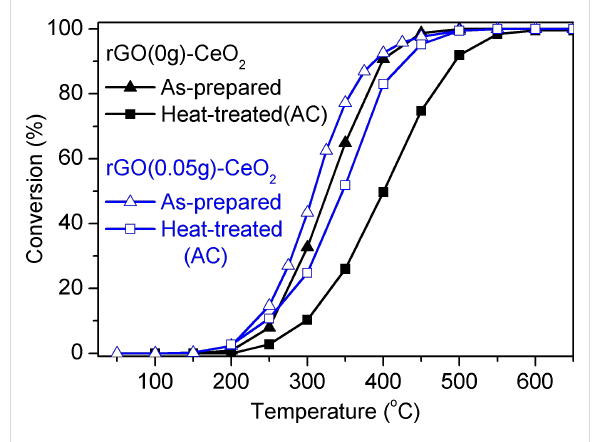
Figure 6: CO oxidation at different temperatures for CeO 2 with rGO- like organic residues (rGO(0)–CeO 2 ) and the rGO(0.05)–CeO 2 com-